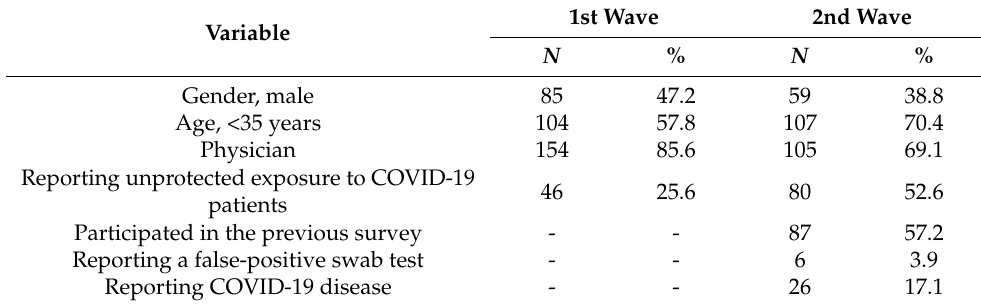
Table 1. Characteristics of the